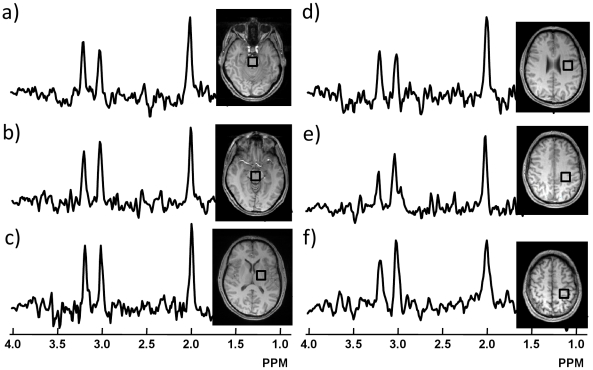
Representative 1H-MR spectra in the brain of a patient with ALS.
1H-MR spectra obtained at 3T from six anatomical regions (square boxes on the MRIs) along the length of the corticospinal tract in the brain of a patient with ALS (male, 43 years) are shown. (a: medulla; b: pons/midbrain, c: left internal capsule; d: left corona radiata; e: left centrum semiovale; f: left precentral gyrus/subcortical white matter). The spectra shown were obtained by averaging spectra from 2.7 mL to 6.0 mL contiguous voxels in that region.